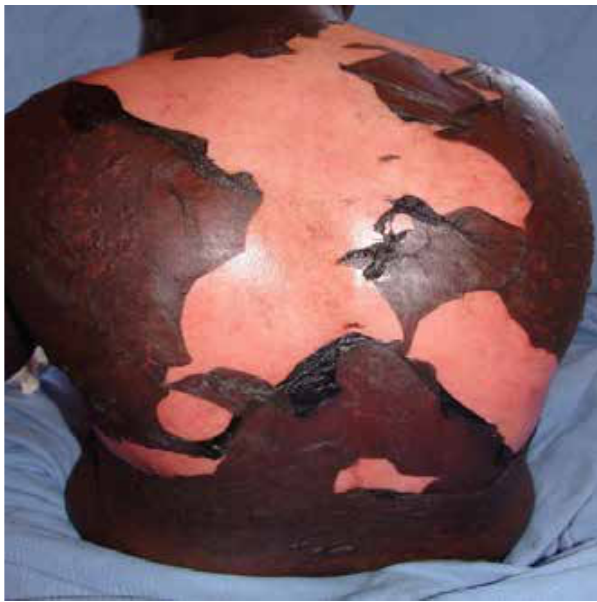
Figure 2: Toxic Epidermal Necrolysis due first line treatment for TB – note greater than 30 % skin